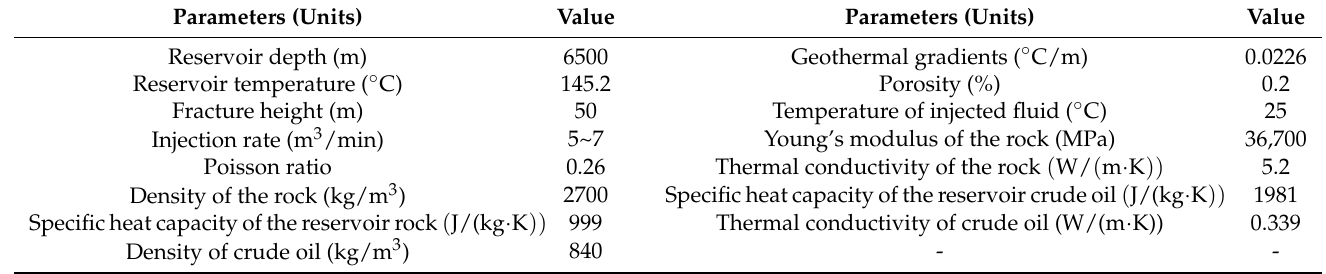
Table 1. Treatment parameters and stratigraphic parameters for Shunbei well #T.